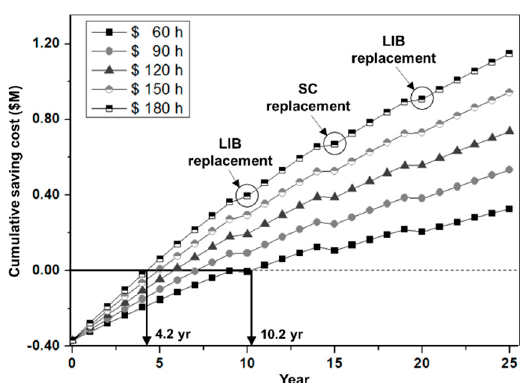
Figure 14. Cumulative saving costs for the lifespan of a ship depending on different cargo handling times (assuming that the ship visits 20 ports per year with a sailing time of 10 days).